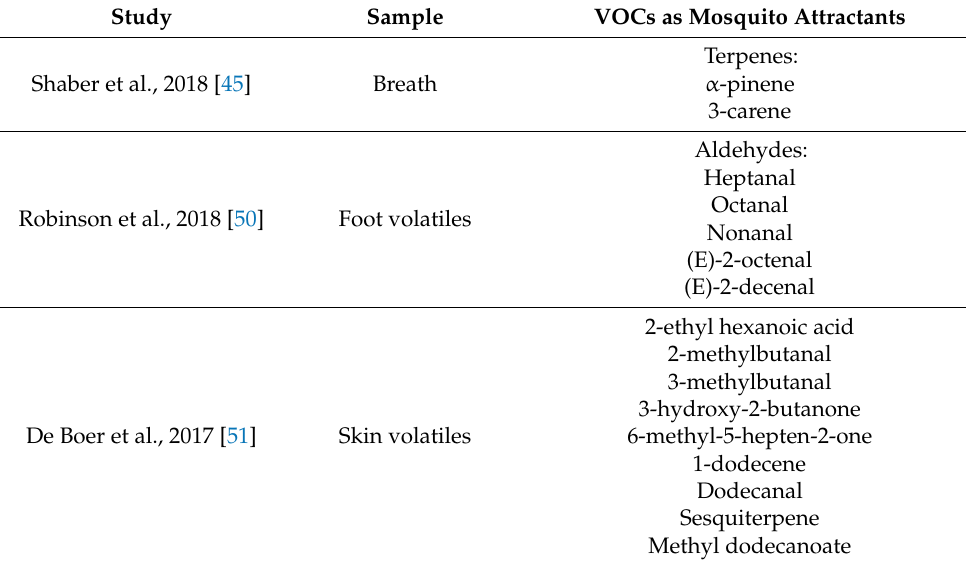
Table 2. VOCs emitted by malaria-infected individuals that enhance mosquito